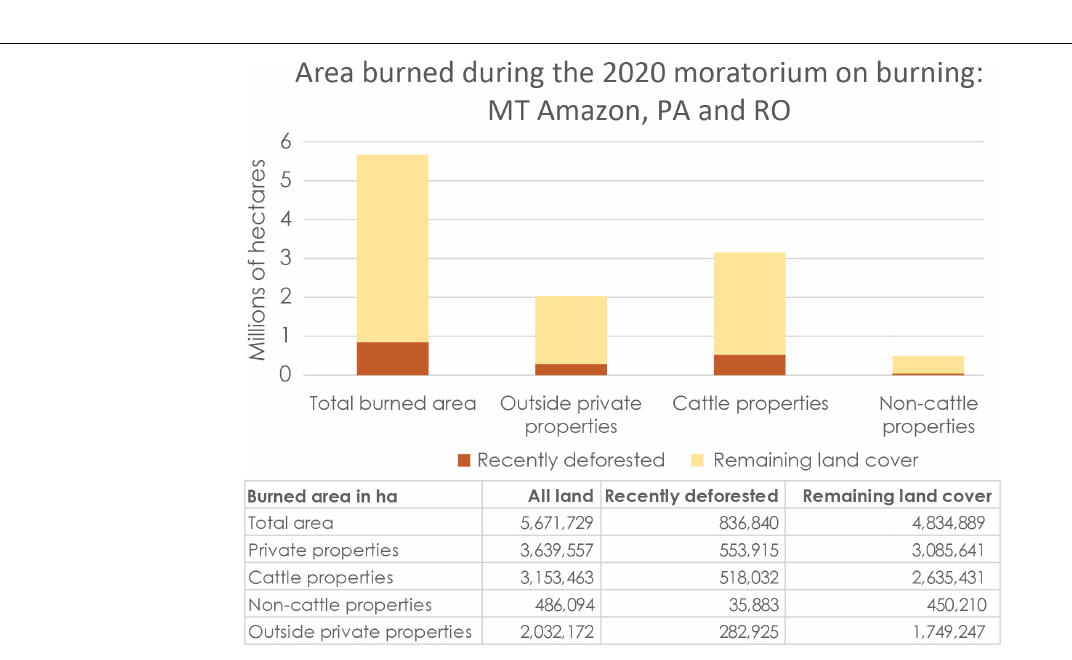
FIGURE 2 | Area burned and location during the fire